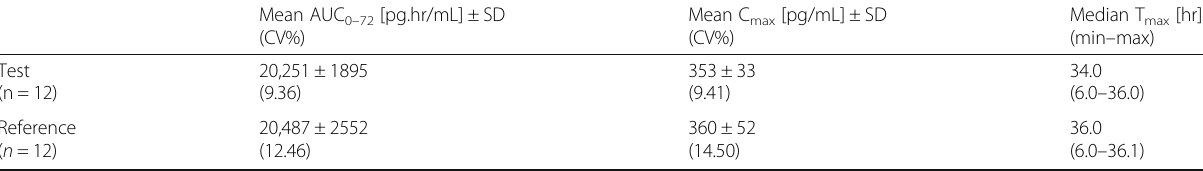
Table 2 AUC 0 – 72 (±SD), C max (±SD), and T max values for Test and Reference